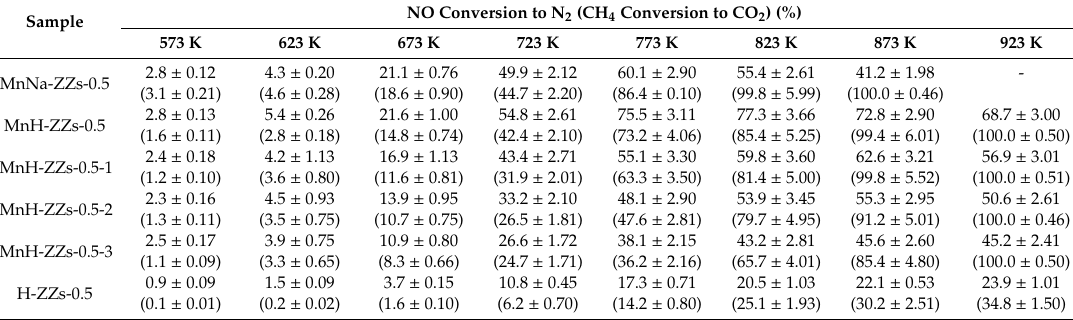
Table 3. E ff ect of the Mn content in the MnH-ZZs-n on the catalytic activity.